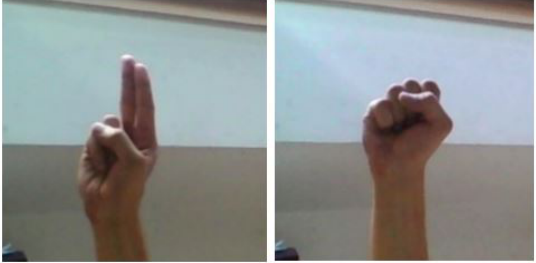
Figure 12. The alphabet “U” and alphabet “S” from the ASL dataset that are wrongly